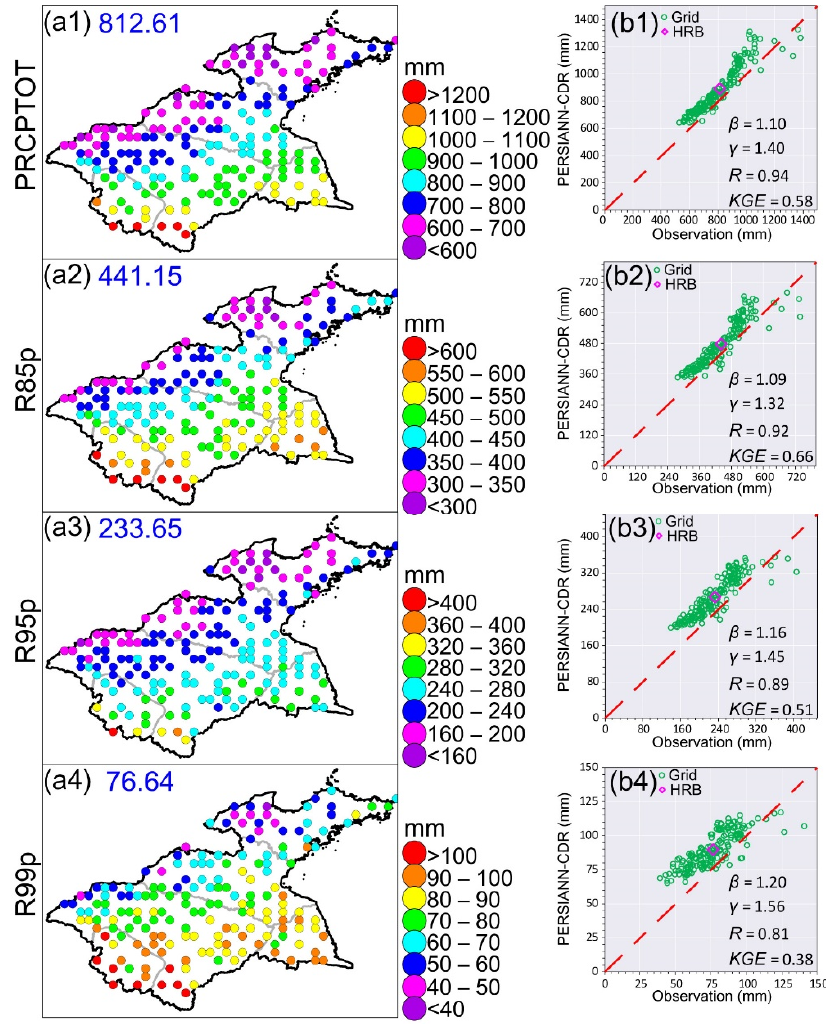
Figure 2. Spatial patterns of multi-year annual means of observational amount-based indices and the scatterplots between observation and PERSIANN-CDR. a1 – a4 ( b1 – b4 ) are for PRCPTOT, R85p, R95p, and R99p, respectively. In a1 – a4 , the blue numbers represent the HRB mean for a given extreme precipitation index. The red dashed line within b1 − b4 is the 1:1 line.